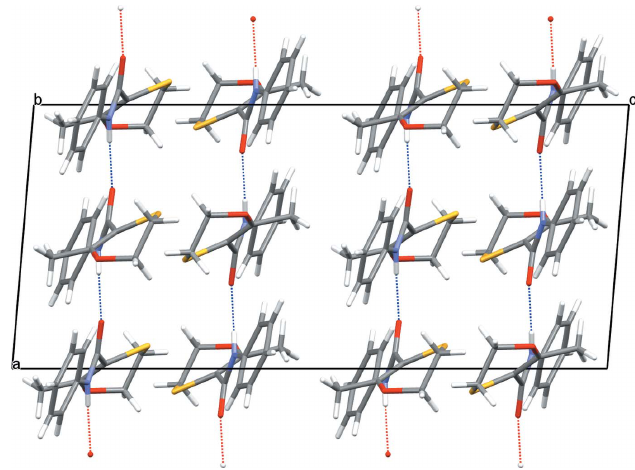
Figure 6 View of the crystal packing of form 1 as viewed approximately down the a axis. The N—H (cid:2)(cid:2)(cid:2) O hydrogen bonds are shown as dotted lines (see Table 1 and text).